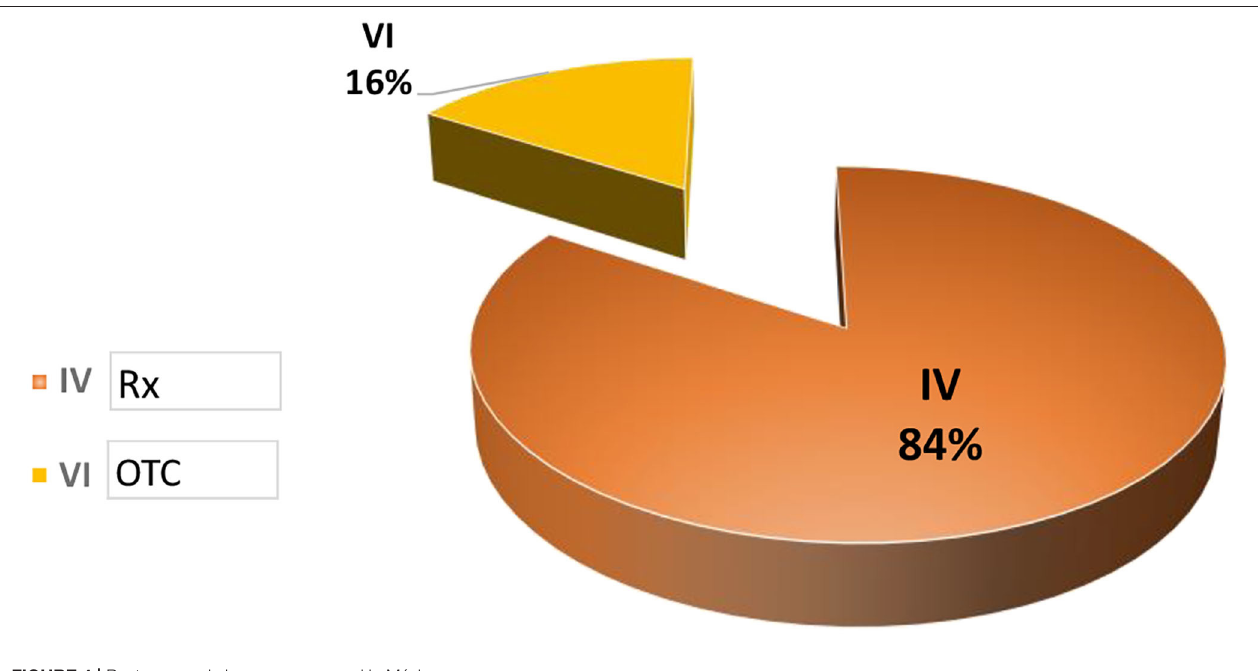
FIGURE 4 | Post-approval changes processed in México.